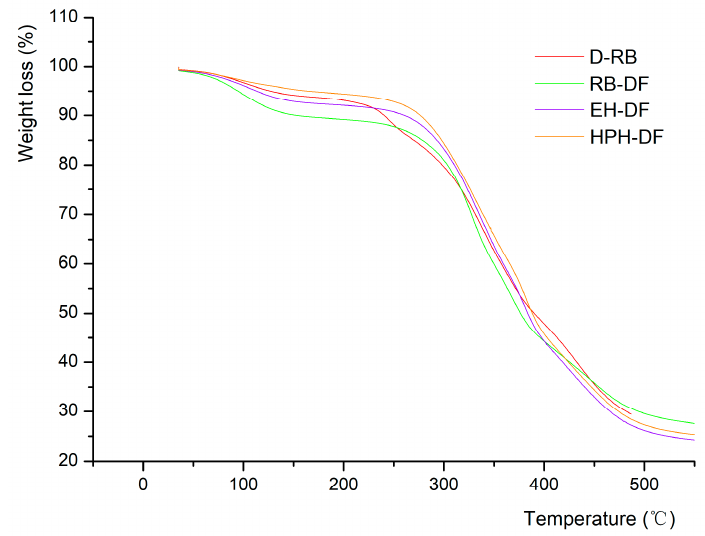
Figure 4. Differential thermogravimetric analysis curves of rice bran dietary fiber at different treatment stages. D-RB defatted rice bran, EH-DF cellulase enzymatic treatment rice bran dietary fiber, HPH-DF high-pressure treatment rice bran dietary fiber, RB-DF rice bran dietary fiber.